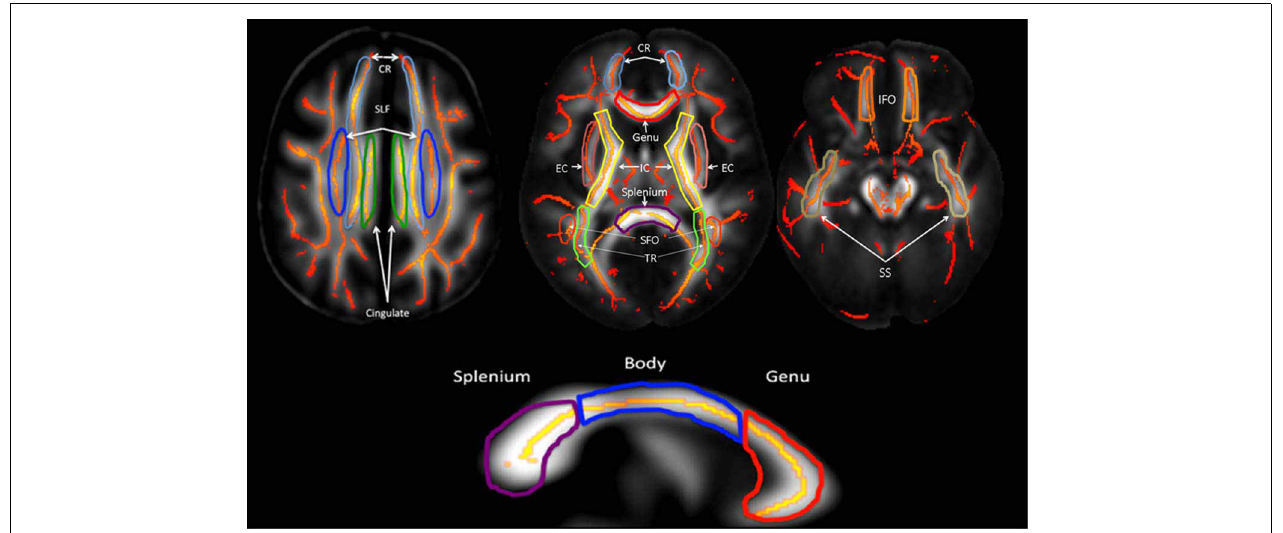
FIGURE 2 | Average DTI FA values were measured for ten major cerebral WM tracts (Table